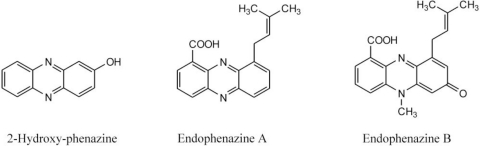
Structures of selected phenazines produced by Pseudomonas chlororaphis subsp. chlororaphis DSM 50083T and Streptomyces cinnamonensis DSM 1042T.